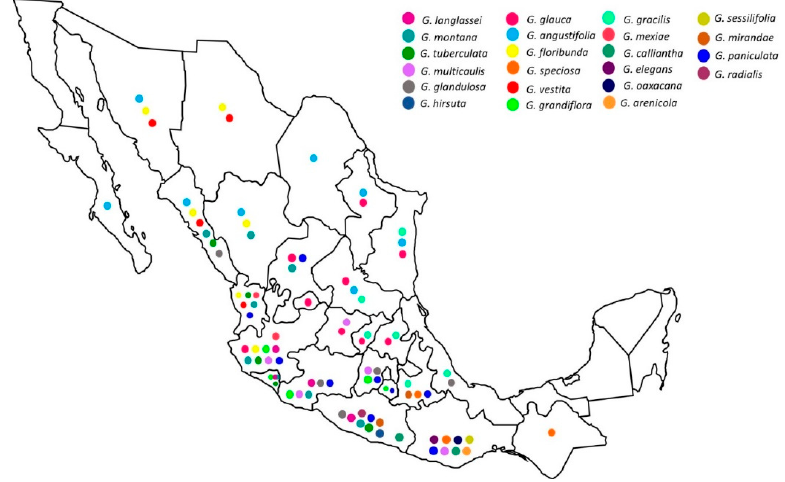
Figure 2. Geographical distribution of the 22 species of the genus Galphimia .